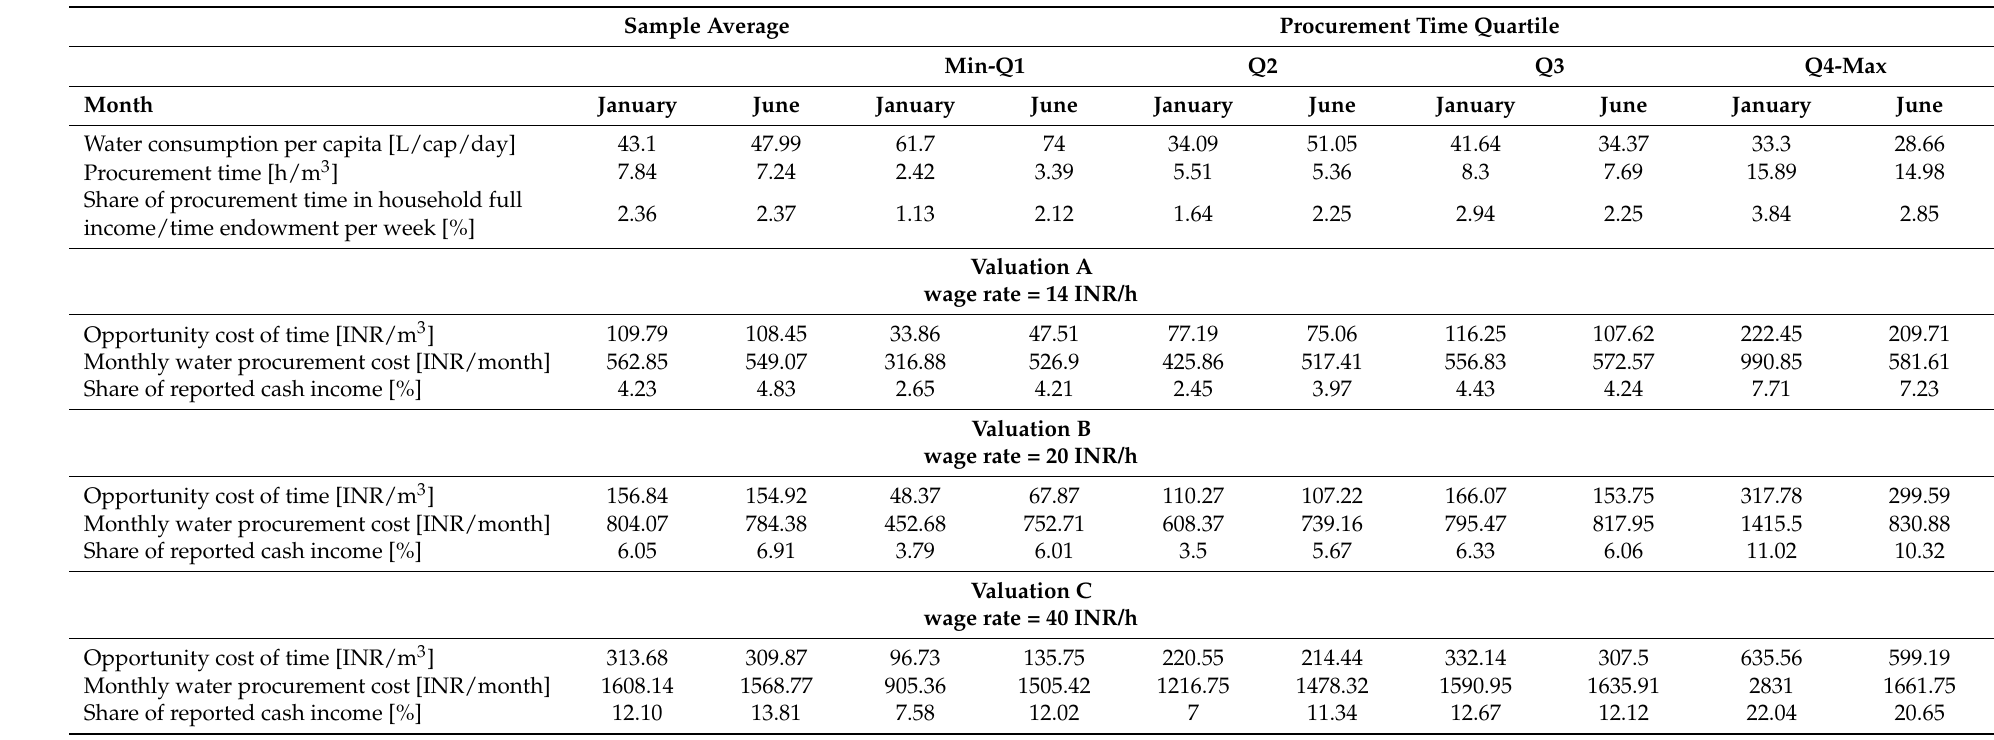
Table 4. Results of time cost valuations (Data source: